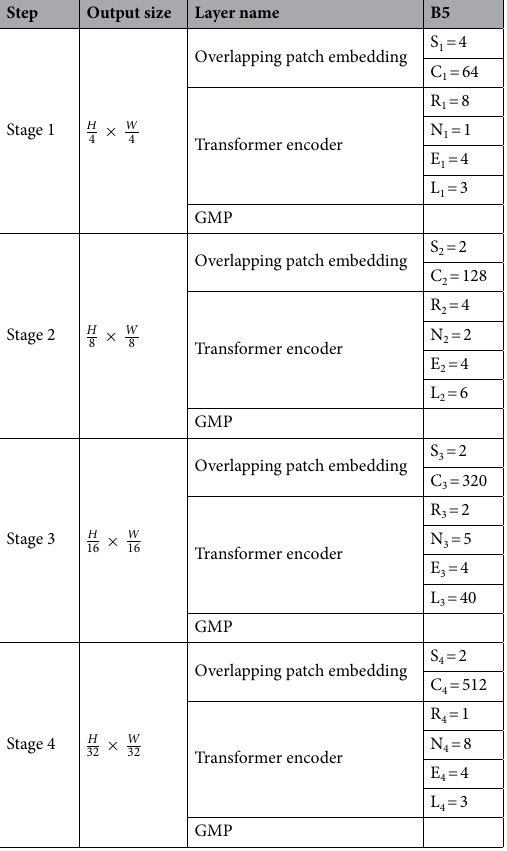
Table 1. The parameters of encoder of WSITrans network. It refers to the “PVTv2 B5”, and we perform global maximum pooling (GMP) at the end of stage